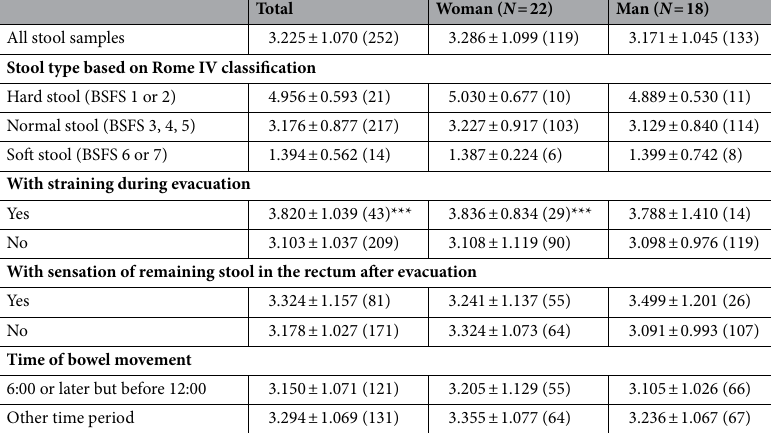
Table 1. Stool consistency variation according to gender, stool type, stool symptoms, and defecation time. Stool consistency (ln g) is expressed as mean ± SD of results of stools in each category or subgroup. The effect size of each factors (gender, stool type, stool symptoms, and defecation time period) on stool consistency was evaluated by linear mixed models. *** P < 0.001 (between Yes and